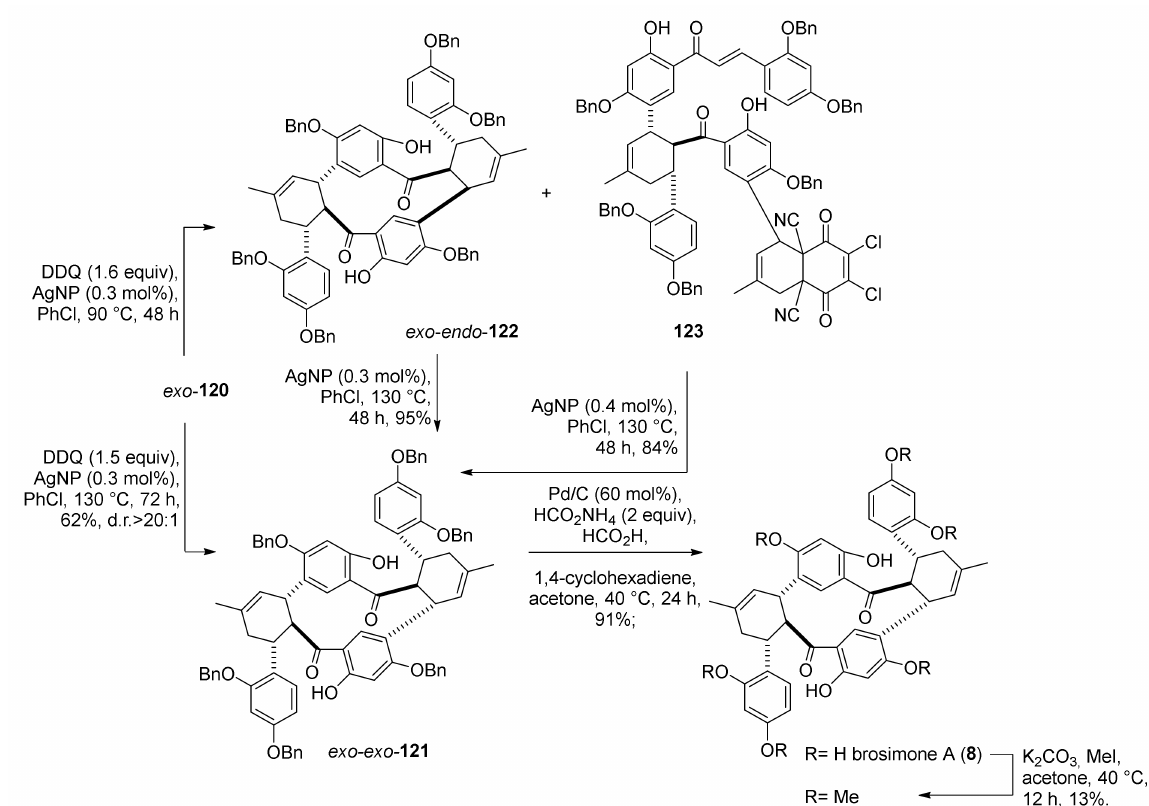
Figure 39. DHDA toward brosimone A derivative exo-exo- 121